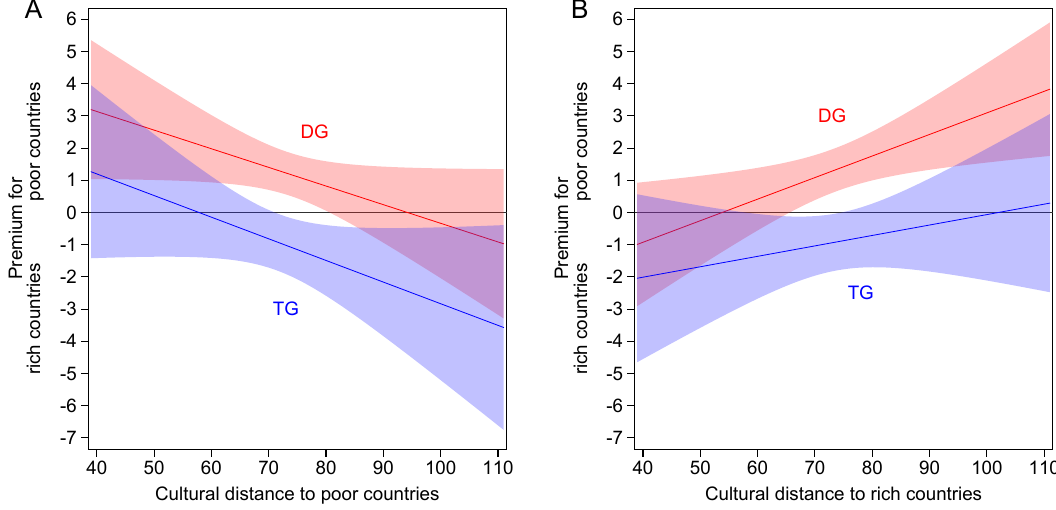
Figure 2: Cultural distance moderates the distinct status effects on generosity and trust. We plot the mean difference in transfers to poor minus rich countries in the dictator game (DG; red) and the trust game (TG; blue) against the cultural distance to either ( A ) poor-country counterparts or ( B ) rich-country counterparts (95% confidence intervals based on robust standard errors). Generosity and trust decrease with cultural distance. The status effect is stronger when the cultural distance to poor countries is small in the DG (see panel A ). Likewise, the status effect in the TG is evident only if the cultural distance to rich countries is small (see panel B